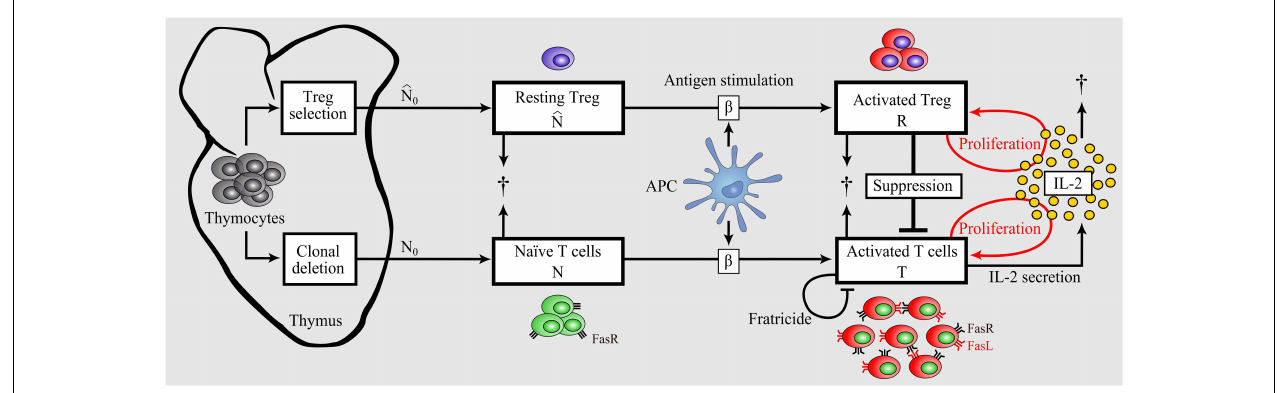
activated. In contrast to activated T cells, activatedTregs do not secrete IL-2, but both activated populations proliferate in dependence on the presence of IL-2 (46). ActivatedTregs suppress activated T cells in a cell-contact- dependent and cytokine-driven manner. Activated T cells undergo Fas- induced apoptosis by interacting with each other (fratricide). In contrast, Tregs are resistant to Fas-induced apoptosis